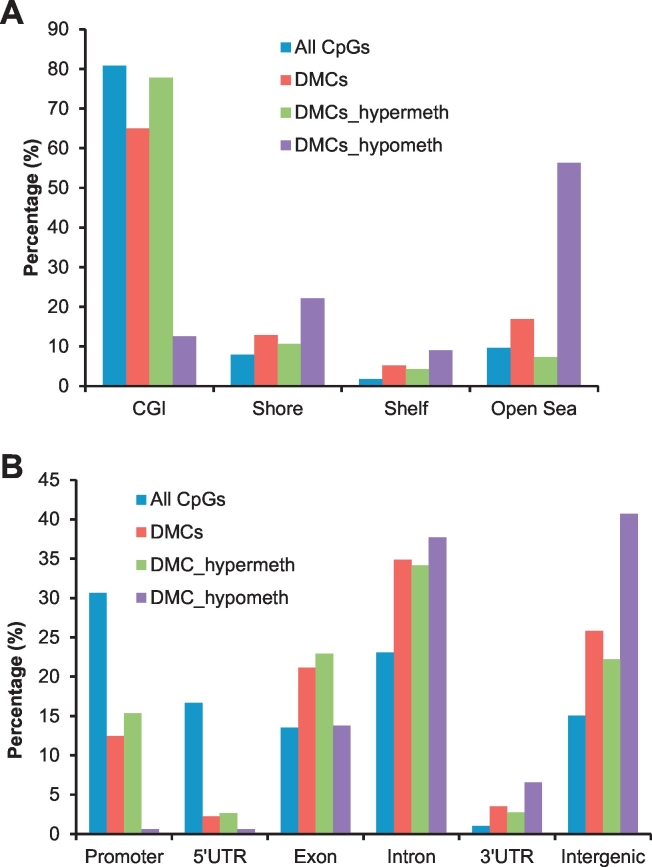
Distribution of all 182,518 tested CpGs and 852 significant osteoblast-specific DMCs, including 685 hypermethylated and 167 hypomethylated DMCs, across (A) different regions related to CGIs and (B) different genic regions.